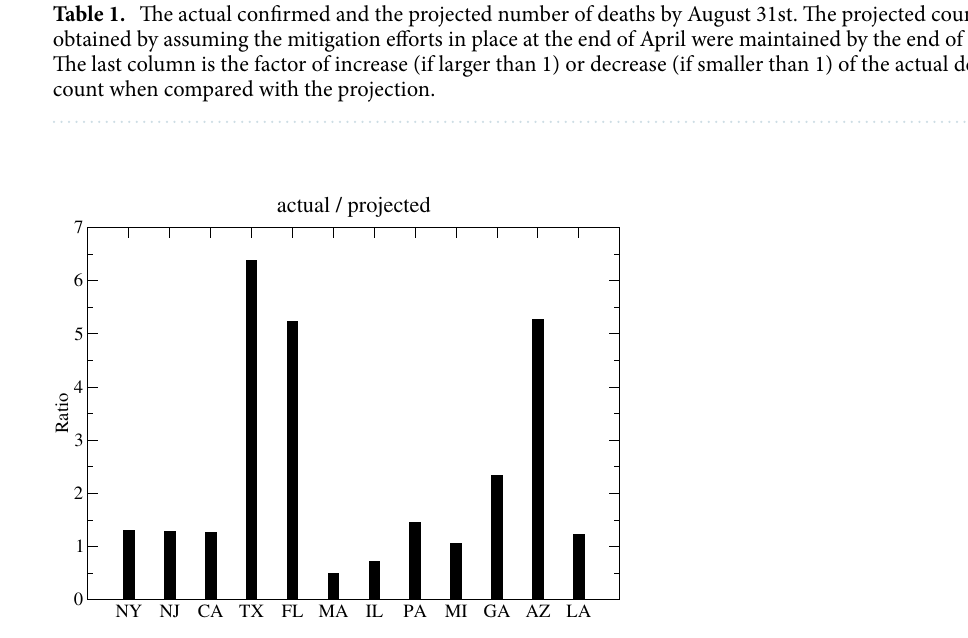
Figure 3. Bar chart with the ratio between the actual and the projected death count by the end of August for the twelve states with the largest counts. The projected count is calculated assuming that the mitigation efforts have been maintained since the end of April. This projection represents the ideal upper bound for the number of casualties as other factors which should lower the death count are not taken into account in the present model. See the text for details. Most states are within 50% of the projection. Two states, Massachusetts and Illinois, demonstrate a lower death number relative to the projections. Three states, Texas, Florida, and Arizona, show a substantial increase relative to the projections. Another state which shows an increase greater than a factor of two is Georgia. Notes: The data can be found in Table